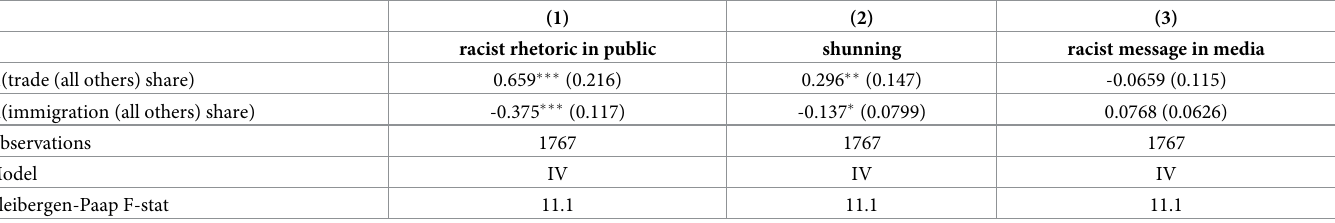
Table 4. Received discrimination by